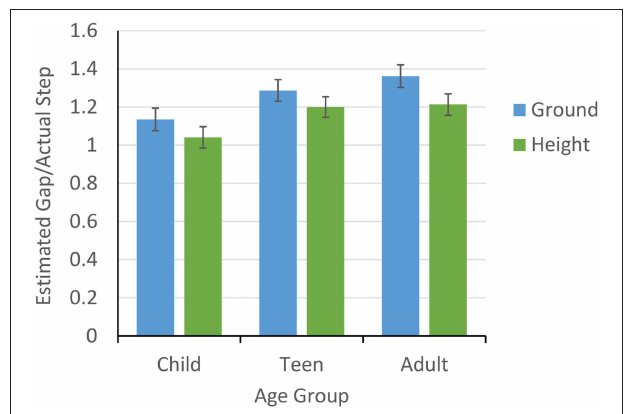
FIGURE 4 | Mean ( ± 1 SE) gap estimates scaled by actual step for child, teen, and adult age groups.